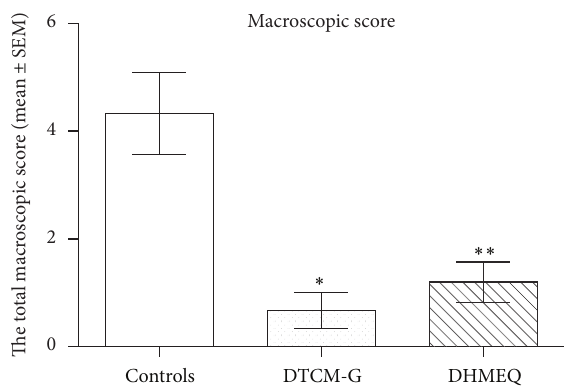
Figure 4: Total macroscopic inflammation scores in control and treated rats at the end-point of the experiment. ∗ 𝑃 < 0.05 and ∗∗ 𝑃 < 0.01 versus